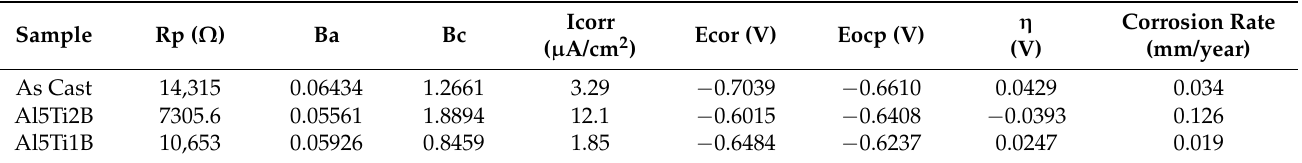
Figure 14. Open circuit potential from as-cast condition without grain refiner; grain refiner Al5Ti2B; grain refiner Al5Ti1B. Table 5. Corrosion results for different